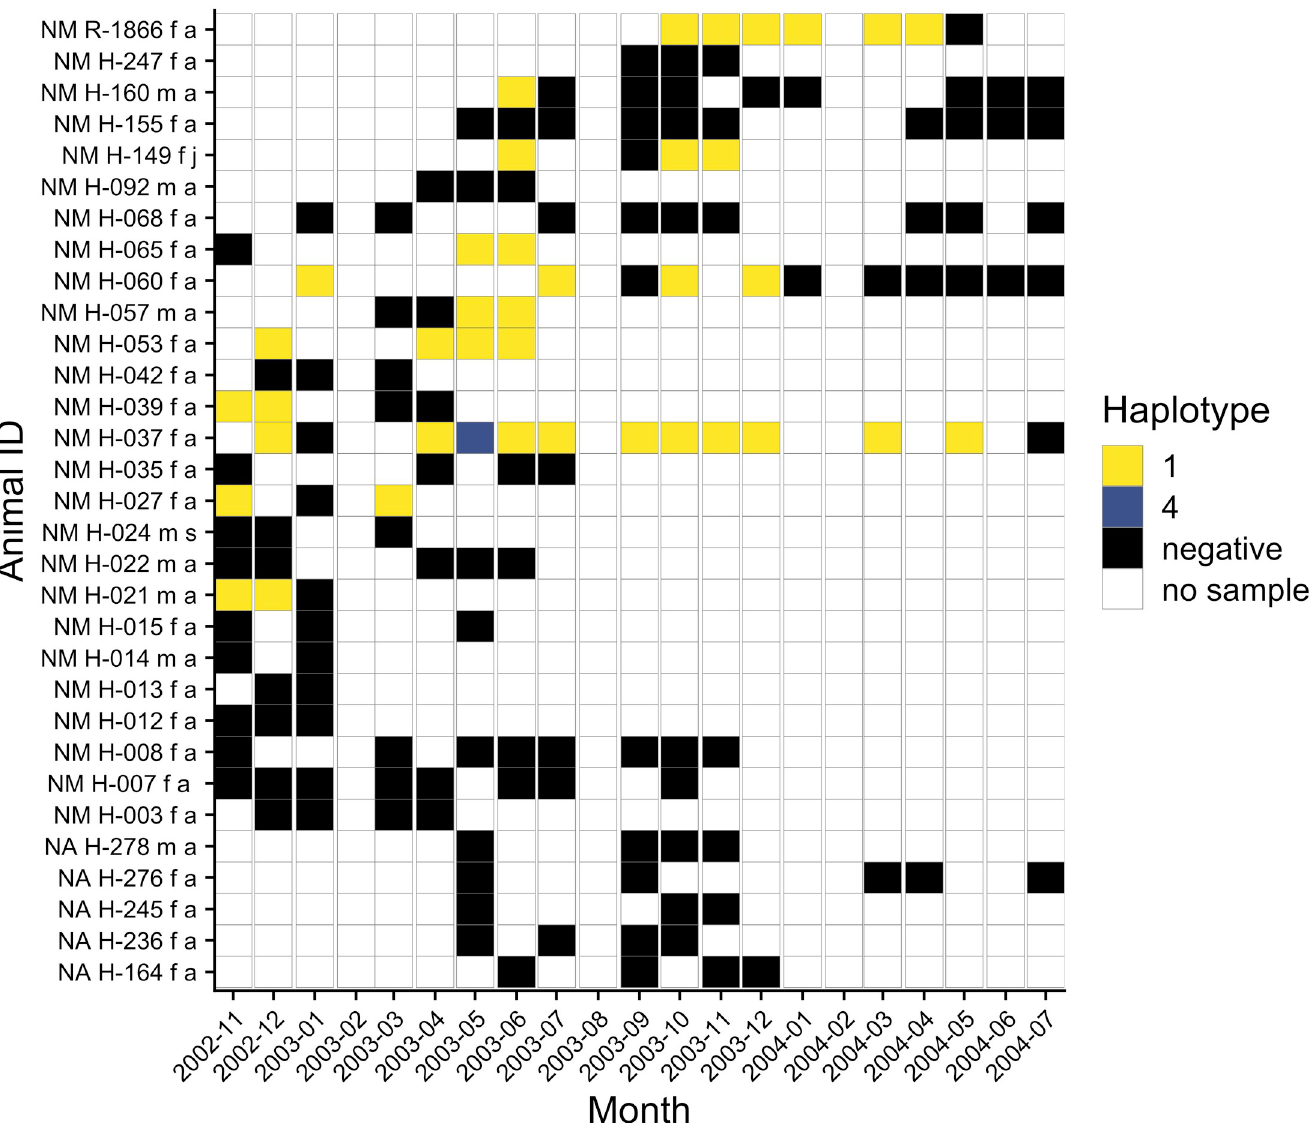
Fig 4. Resampling history and Trypanosoma haplotypes in 31 woodrats (NM = Neotoma micropus and NA = Neotoma albigula ) captured three and more times during the 21 sampling months of the study. The Trypanosoma haplotypes amplified from infected woodrats in a sample month are shown with different colors.